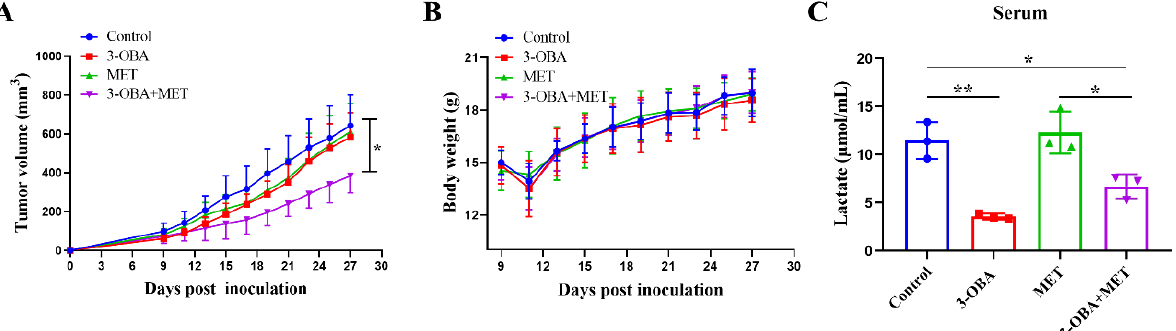
Figure 3. The combination of 3-OBA and metformin inhibits HT29 tumor cell growth in vivo. BALB/c nude mice ( n = 6) were intraperitoneal injected with 75 mg/kg of 3-OBA, 200 mg/kg of metformin, and the combination, ( A ) tumor volumes and ( B ) body weights were measured every other day. ( C ) Lactate concentration in serum after different treatments. * p < 0.05, ** p < 0.01.